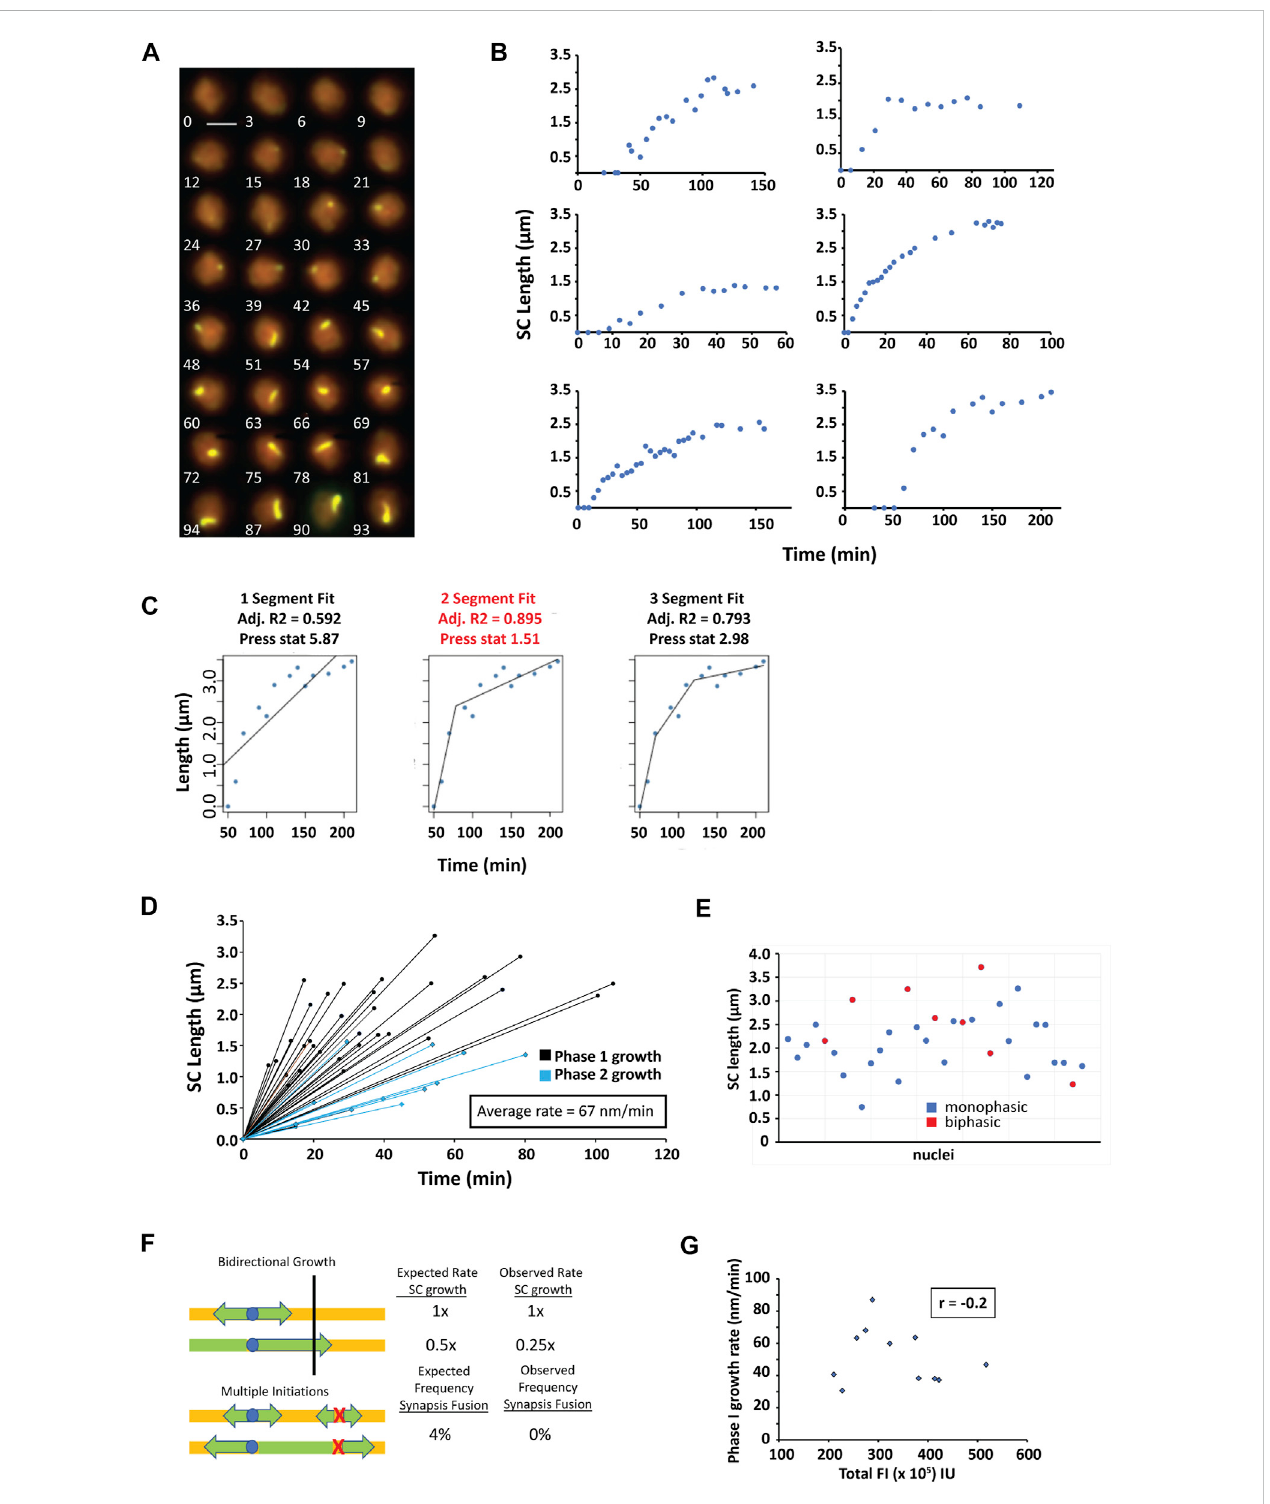
Synapsis assembly. (A) A time series of 2D max-sum projections at 3-min intervals from 3D image stacks of a single nucleus undergoing synapsis assembly visualized by Zip1-GFP. Scale bar — 2 µm. (B) Six representative nuclei containing a single chromosome for which SC length was measured as a function of time during SC assembly. (C) Segmented regression was applied to the assembly data using 1 – 3 segments. The best fi t model was determined usingtheadjustedR2(adj.R2)andcross-validatedwiththePRESSstatistic. Best fi tmodelshavethehighestadjustedR2andlowestPRESSstatistic.Inthis example, the 2-segment fi t (text highlighted in red) represents the best model. (D) Both monophasic and biphasic models were found for SC assembly. The initialrateofSCgrowthforbothmonophasicandbiphasicmodelsareshownillustratedasblacklineswithroundmarkers.Forthebiphasicmodels,thesecond SC growth rate is shown as blue lines with diamond markers. (E) Total SC length for all nuclei with monophasic and biphasic growth indicated (blue circles – monophasic , red circles – biphasic) (F) A model in which SC growth initiates bidirectionally from an acrocentric centromere. A faster bidirectional (initial) SC assembly rate is predicted to slow to 50% of the initial rate once the shorter end is reached (top panel). Predicted and observed rates are shown. Expected and observeddetection ofindividualsynapsis initiation sitesfusing into one synapsed chromosome are shown (bottom panel). (G) Plot ofthe